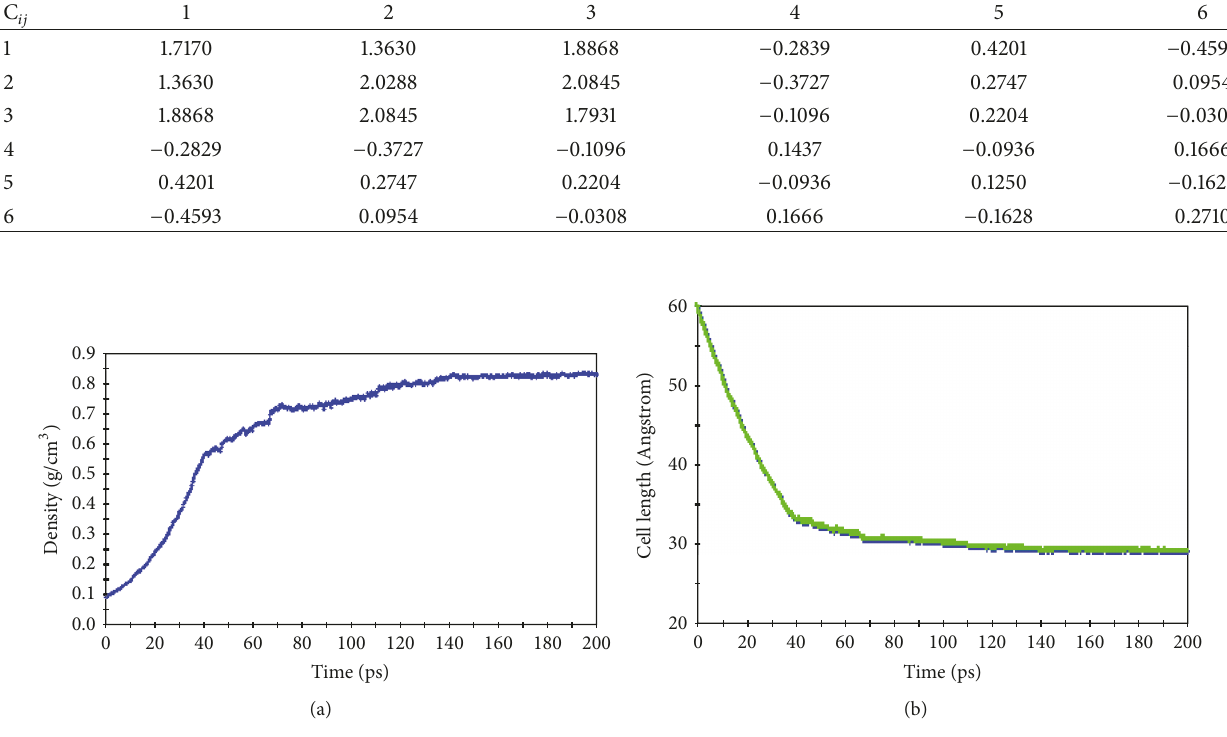
Figure 10: Change of (a) system density and (b) system length of side with time at 0.01 GPa.